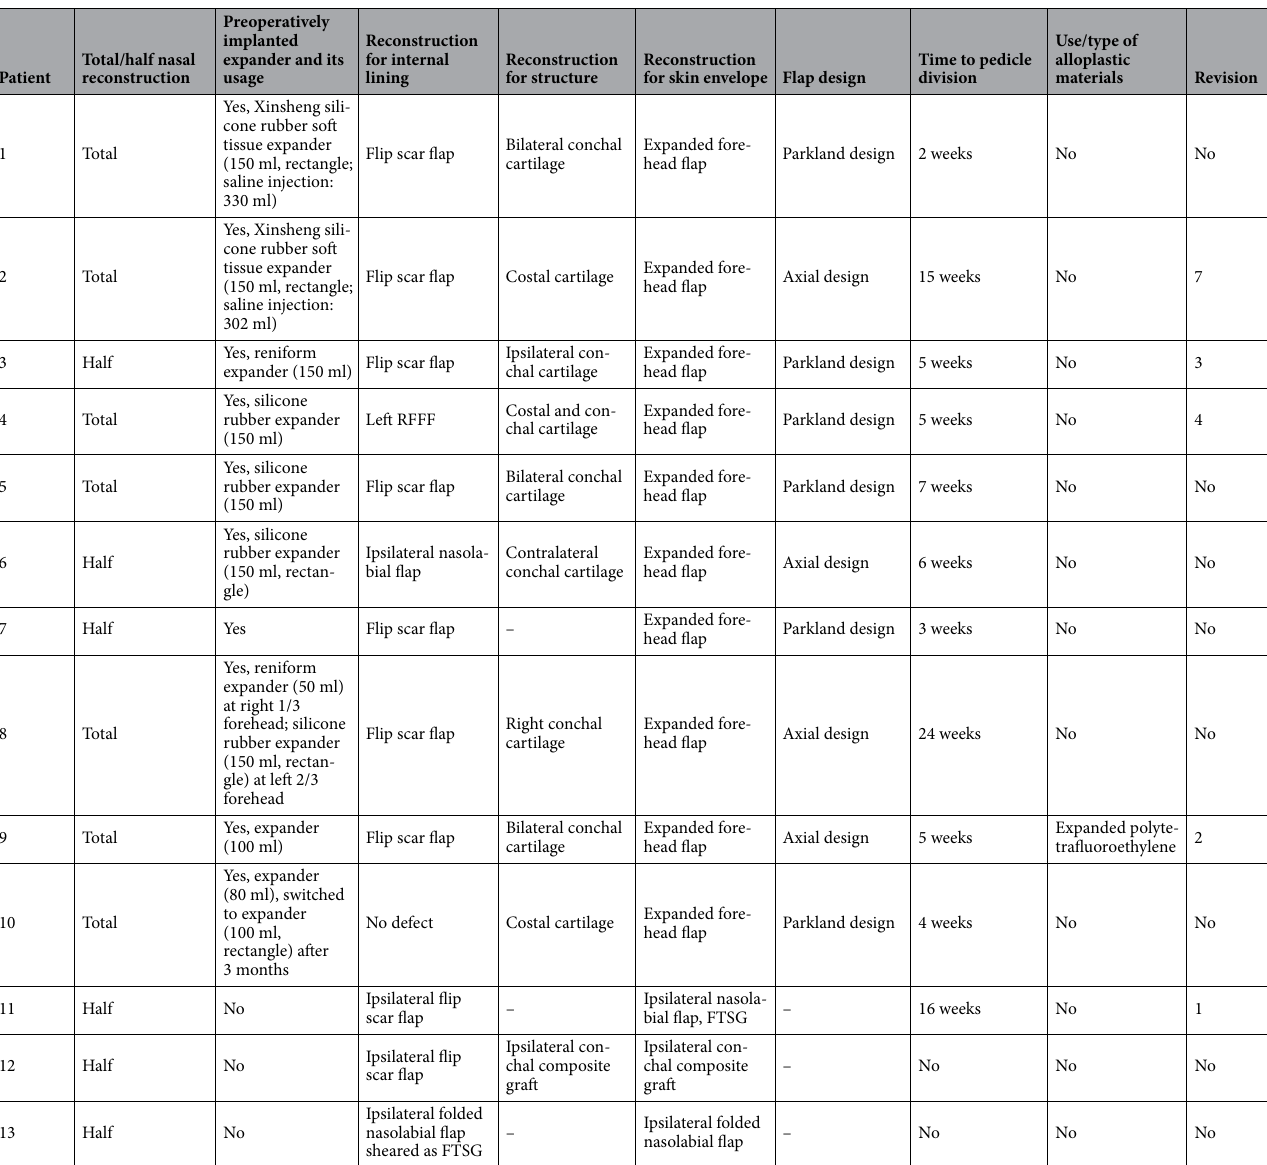
Table 1. Surgical procedures. RFFF radial forearm free flap, FTSG full-thickness skin